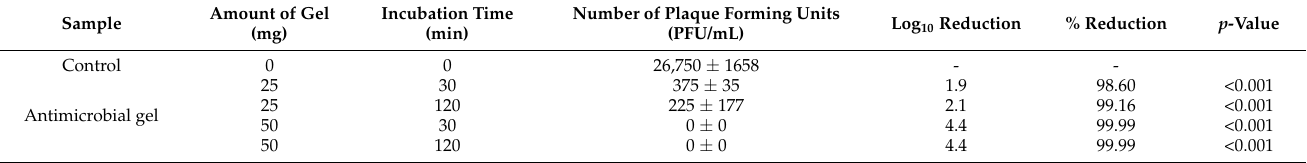
Table 1. Effect of different concentrations of essential oil-containing gel against coronavirus in solution at two time